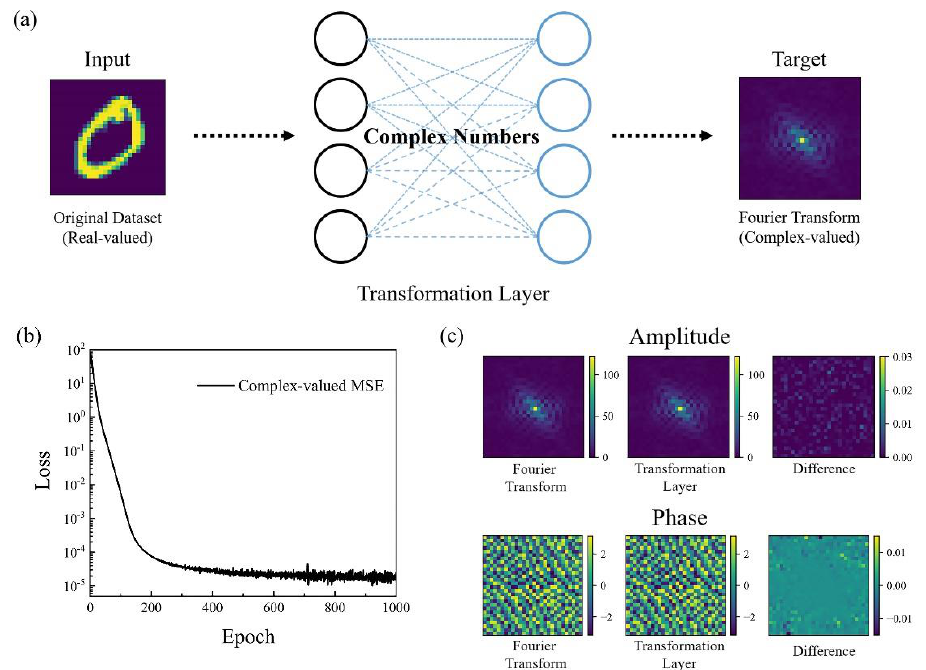
Figure 5. ( a ) Schematic diagram of the transformation layer. ( b ) The loss function curve of the transformation layer on the MNIST training set. ( c ) The amplitude and phase images of the MNIST dataset after Fourier transform and the transformation layer. Difference images are the difference between them.